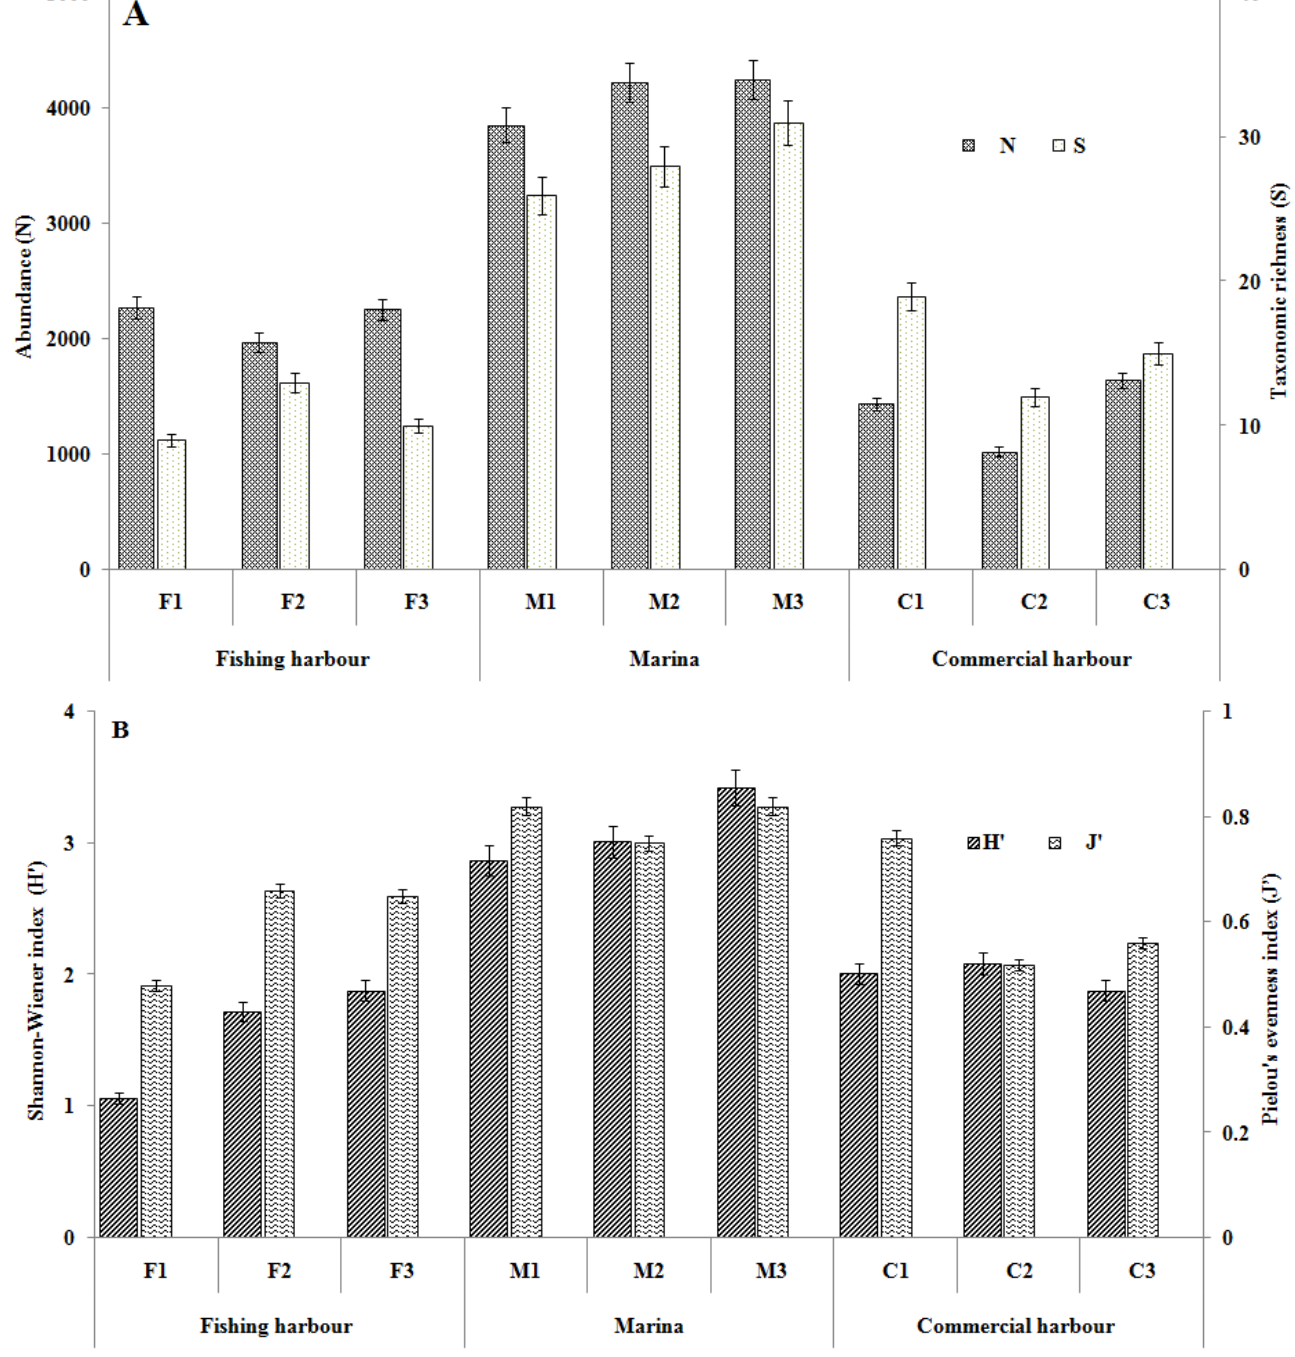
Figure 3. Diversity indices (mean of four replicates ± SD) calculated for each sampled harbour. ( A ): abundance (N; ind·m −2 ) and species richness (S); ( B ): Shannon index (H ′ ; bits·ind −1 ) and Pielou ’ s in- dex (J ′ ).